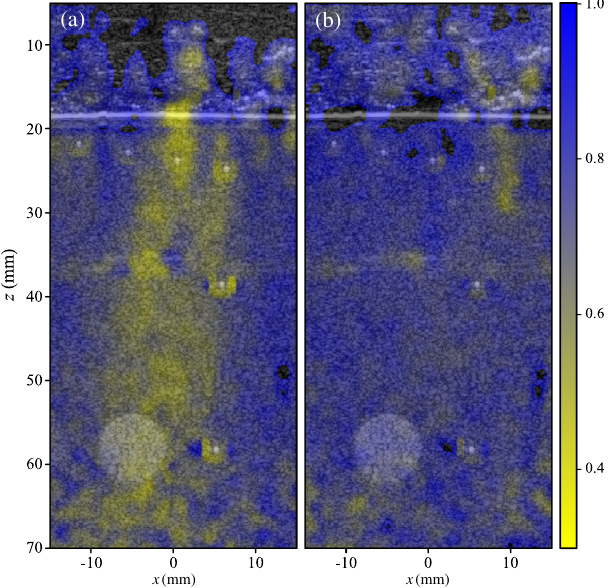
FIG. 3. Maps of local focusing parameter F ð r Þ for the bovine tissue and phantom system, superimposed over the echographic image in Fig. 2(c). (a) The homogeneous model with a constant speed of sound ( c ¼ 1542 m = s) results in a poor quality of focus in some areas. (b) The two-layer model used to construct R rr results in close to ideal focus quality throughout the